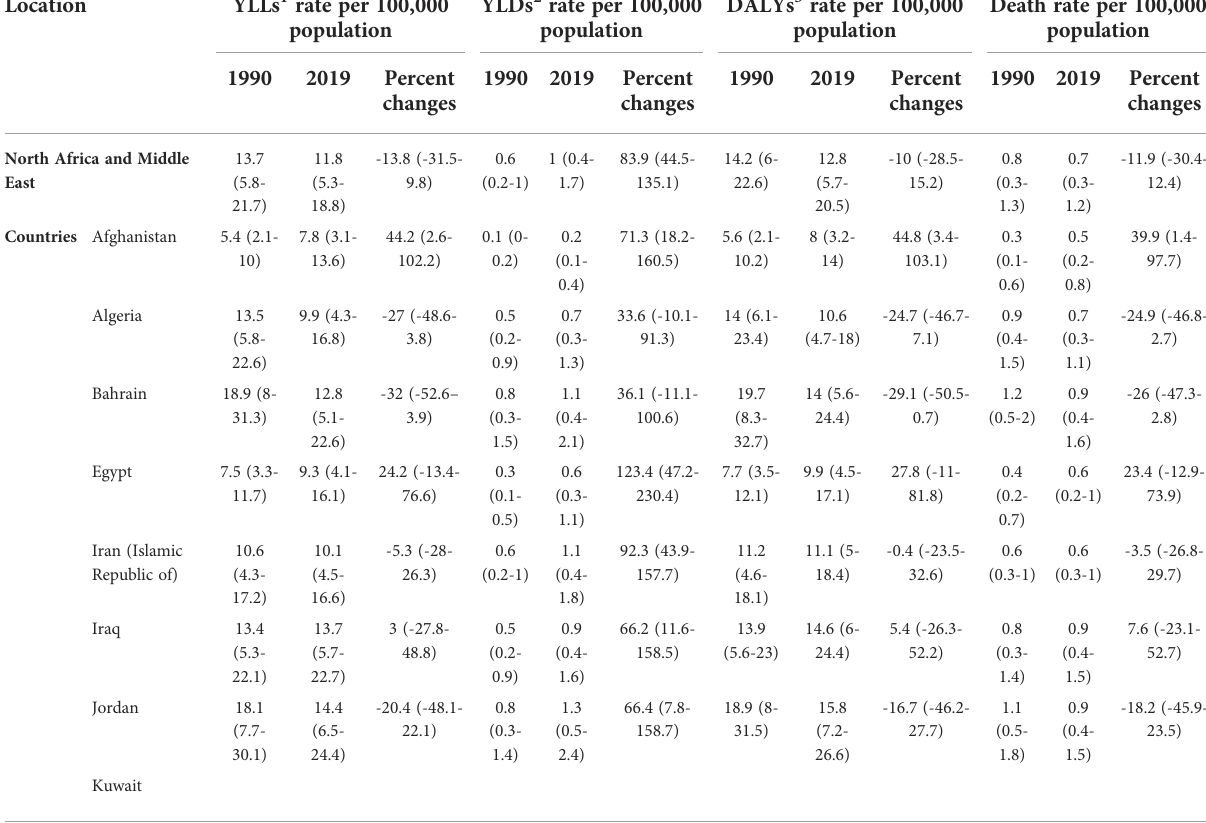
TABLE 3 Age-standardized rates (95% UI) for YLLs, YLDs, and DALYs of prostate cancer attributable to smoking in 1990 and 2019 and their percent changes.